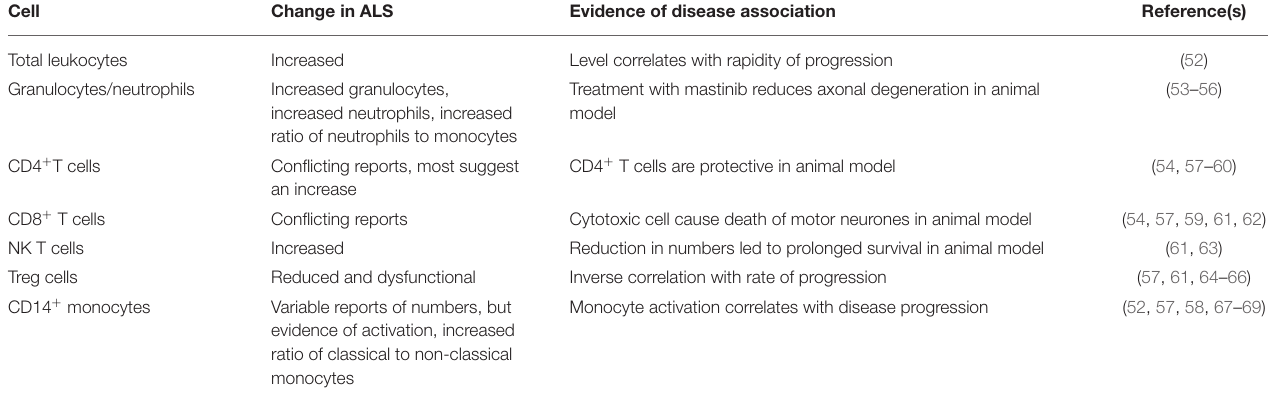
TABLE 1 | Changes in peripheral blood cells in ALS.